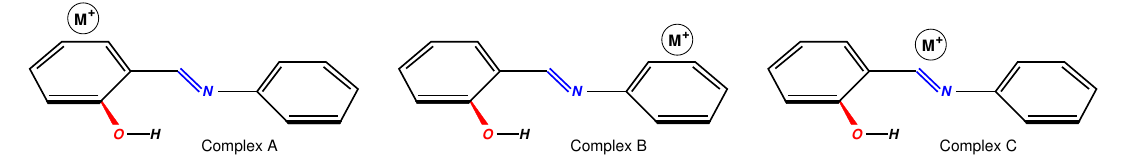
Figure 1. Initial configurations of salicylideneaniline–metal ion